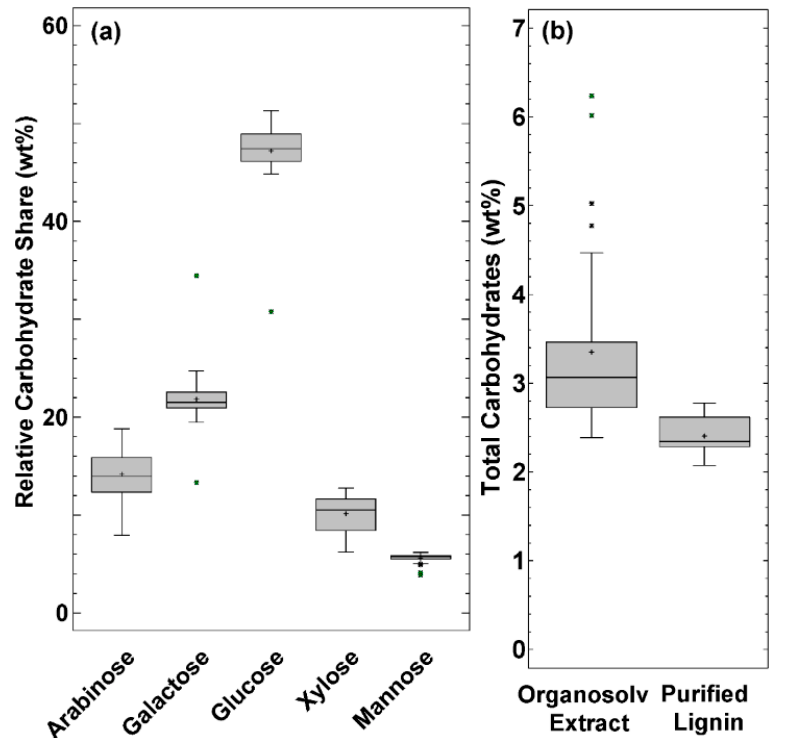
Figure 4. ( a ) Box plot of the relative carbohydrate share found in the 34 single experiments. ( b ) Box plot of the total carbohydrate content in the direct precipitate from organosolv extracts and in the purified lignin (PL). The + indicates the arithmetic mean.